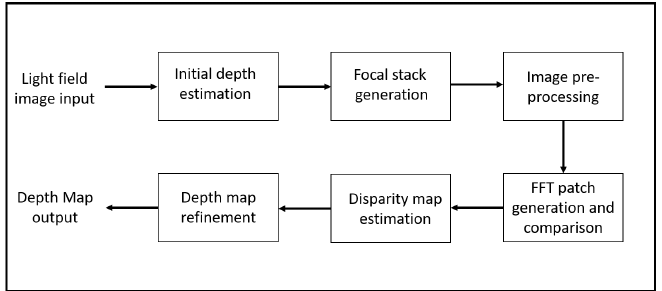
Figure 2. Depth estimation algorithm